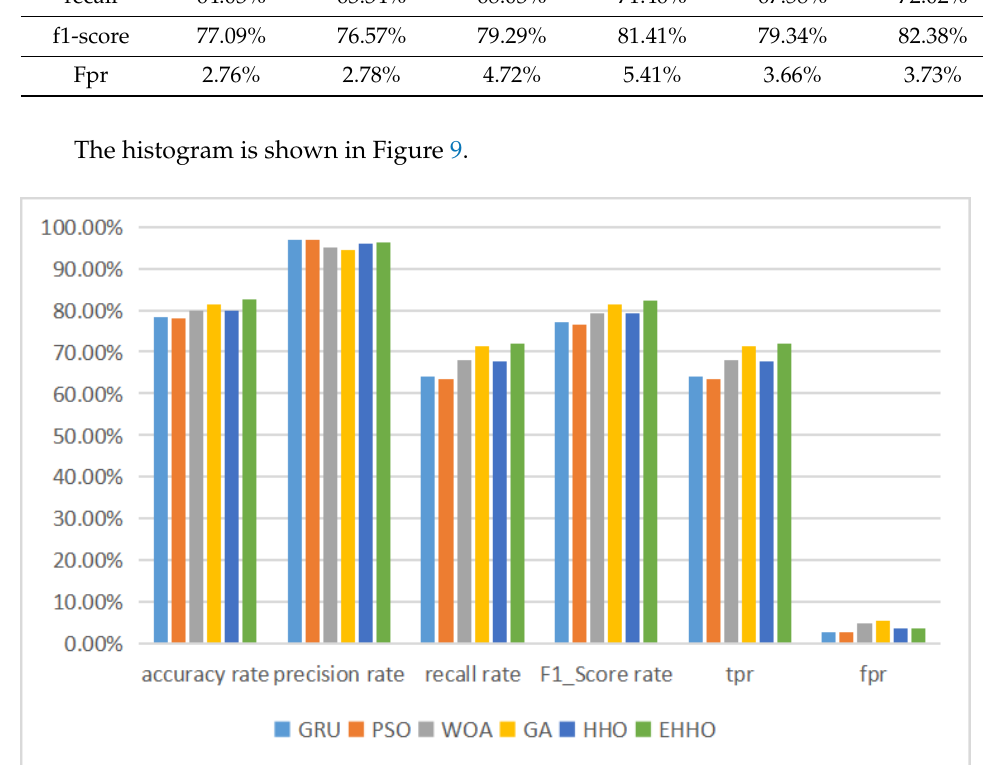
Figure 9. Binary classification histogram of